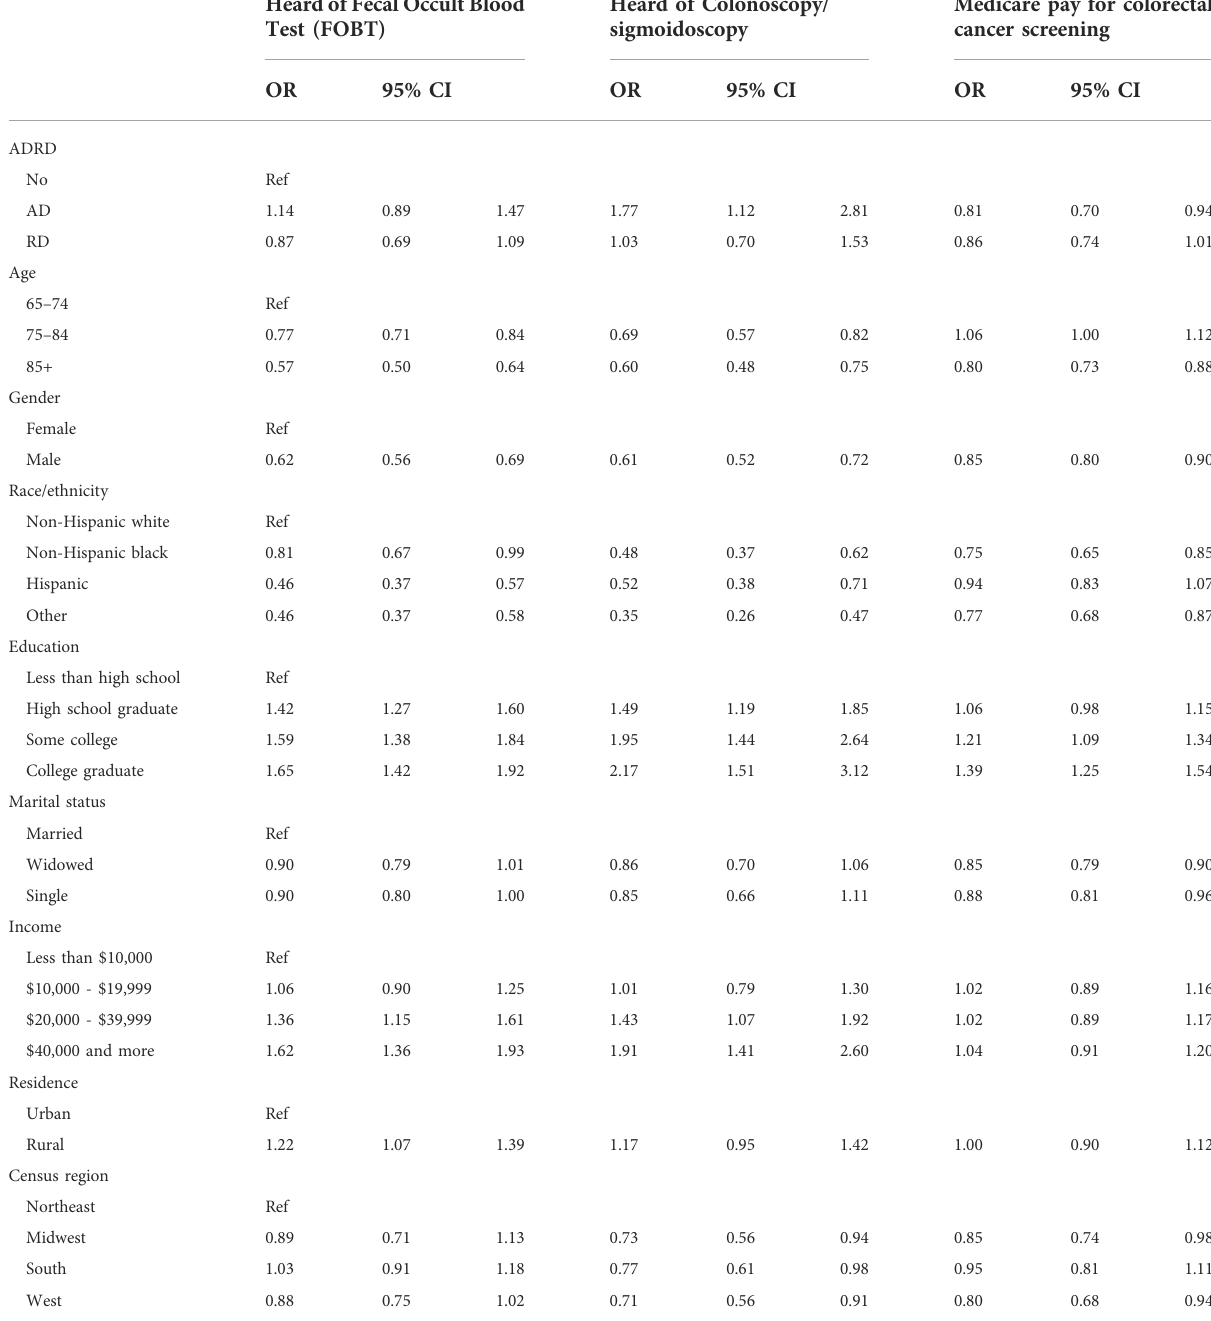
TABLE 3 Factors associated with colorectal cancer screening knowledge. Heard of Fecal Occult Blood Test (FOBT)